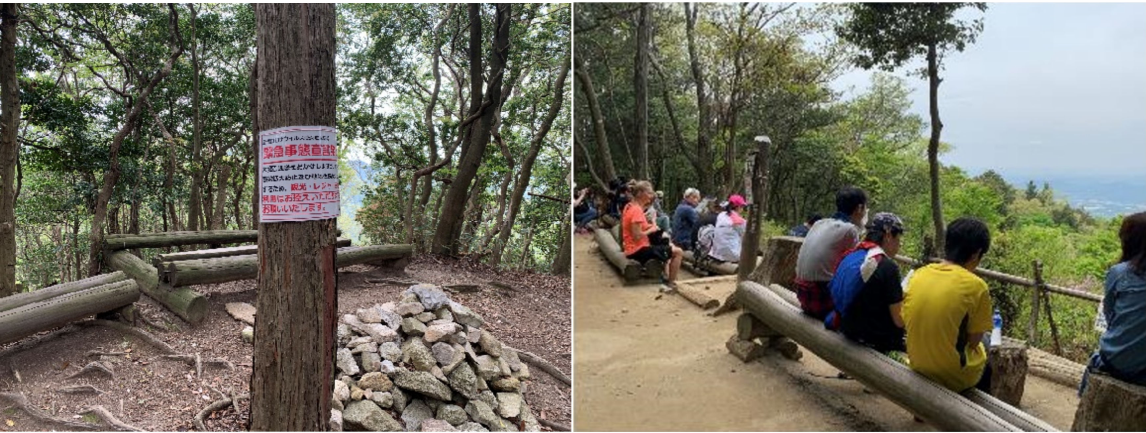
Figure 1. Signage discouraging people from visiting the hiking trail in Aichi Prefecture ( left ) and visitors of the same trail ( right